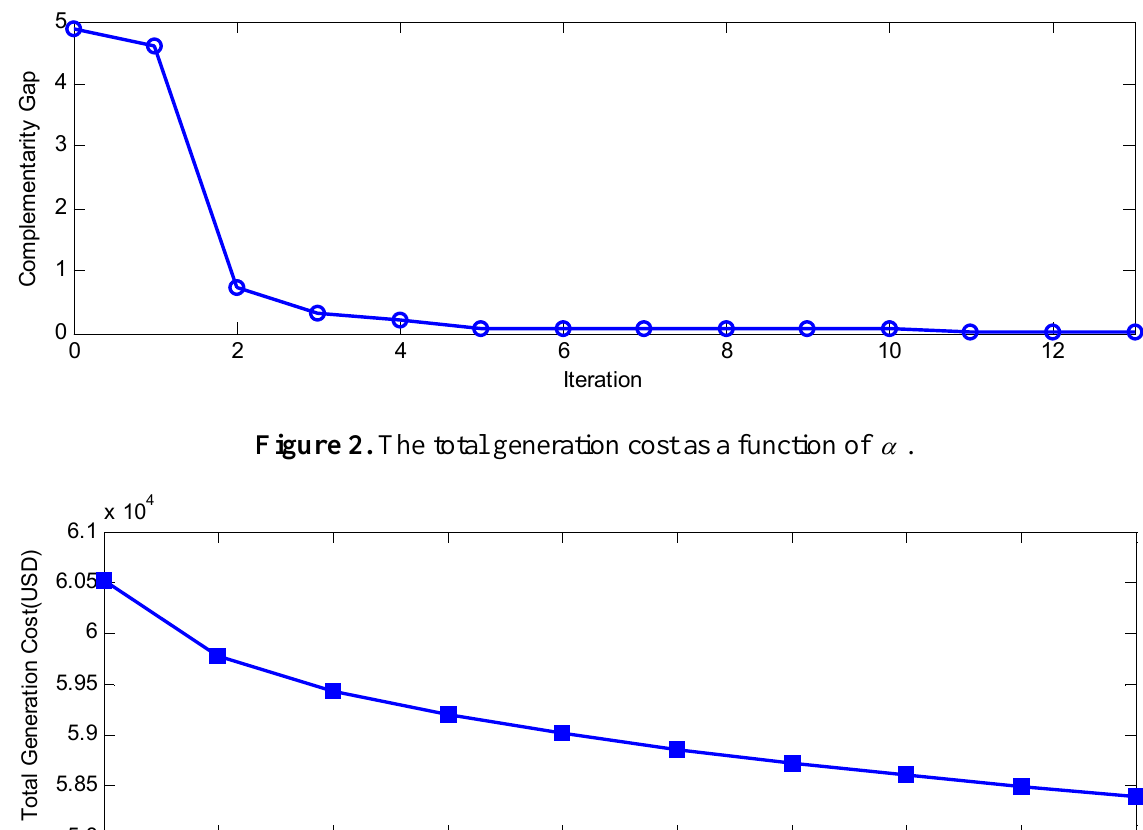
Figure 1. The iteration curve of complementarity gap.